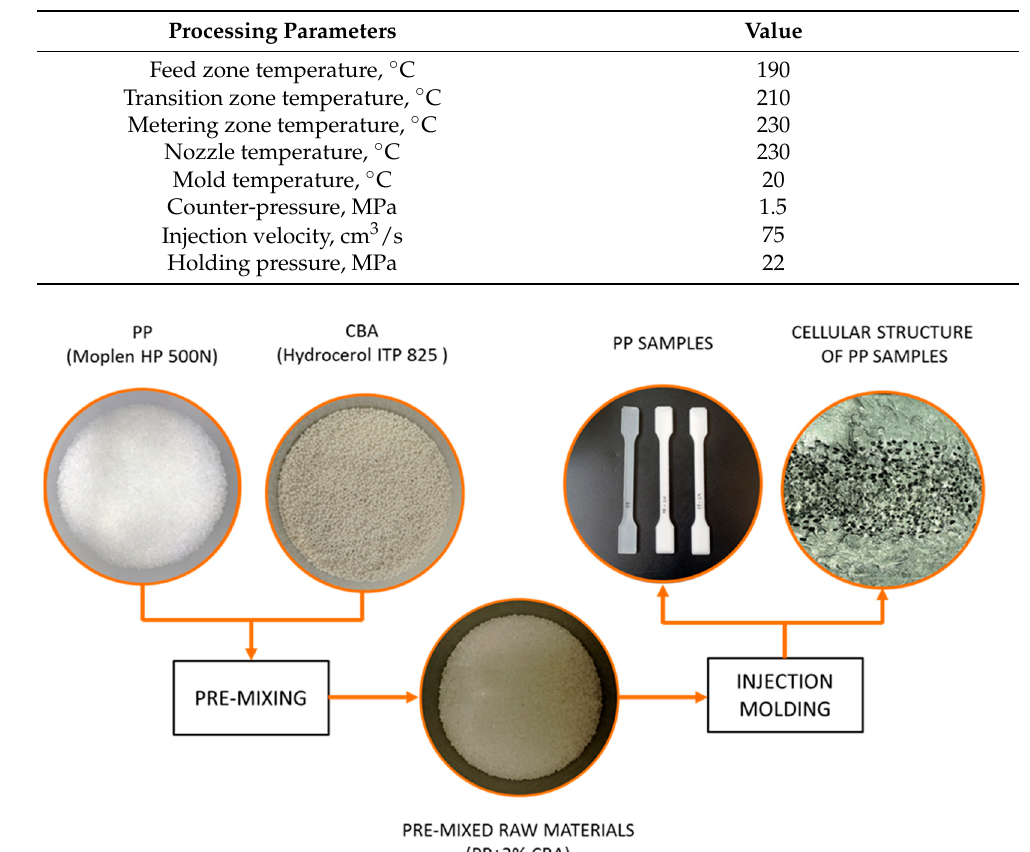
Table 2. Constant parameters of the injection process of PP samples.